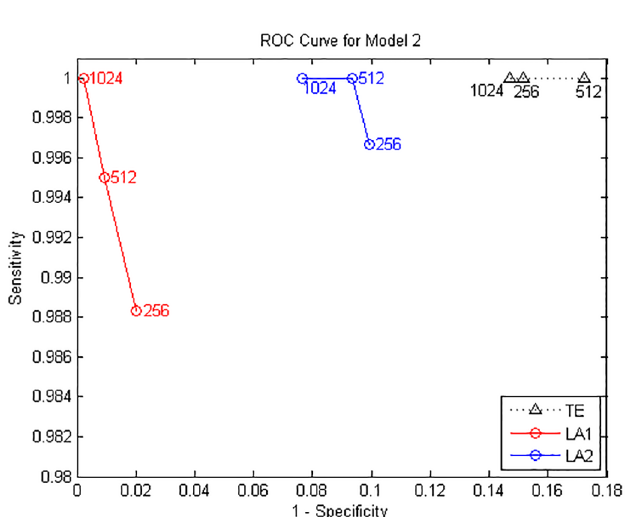
Fig 4. ROC curves for Model B. Sensitivity and specificity are obtained by gradually increasing the time series length from 256 to 1024 points.